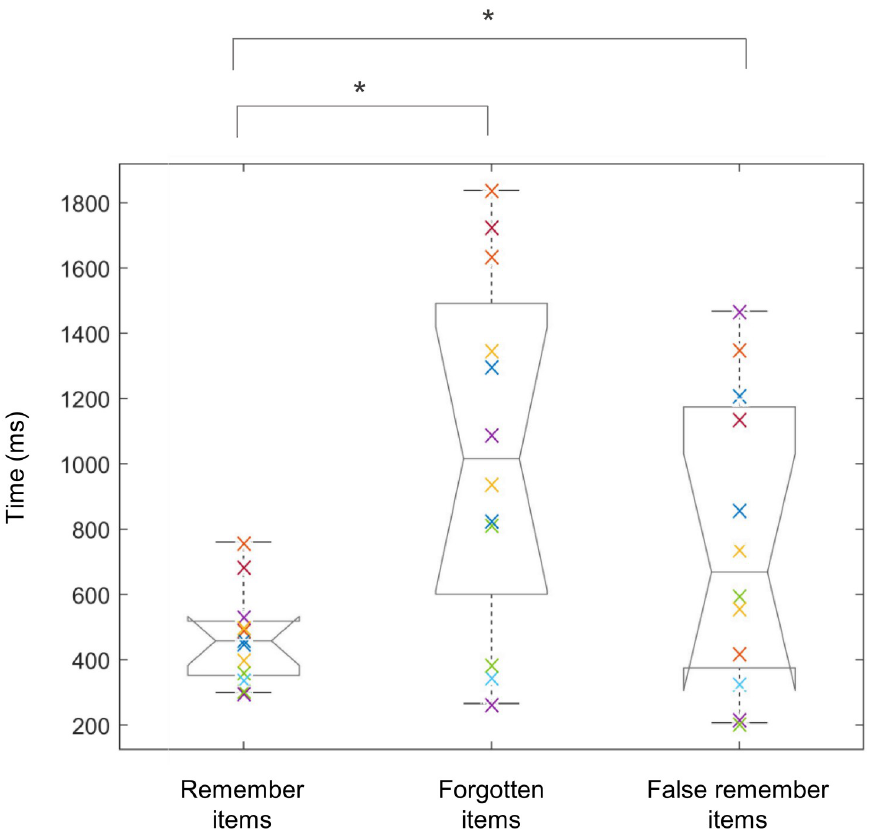
Fig 3. Reaction time of remember, forgotten, and false remember items for all participants and their mean value. Participants took more time to select the recognition confidence levels of forgotten words during the retrieval task. Boxplot indicates the mean, while the error bars indicate the standard deviation ( � p < 0.05 with Bonferroni correction).